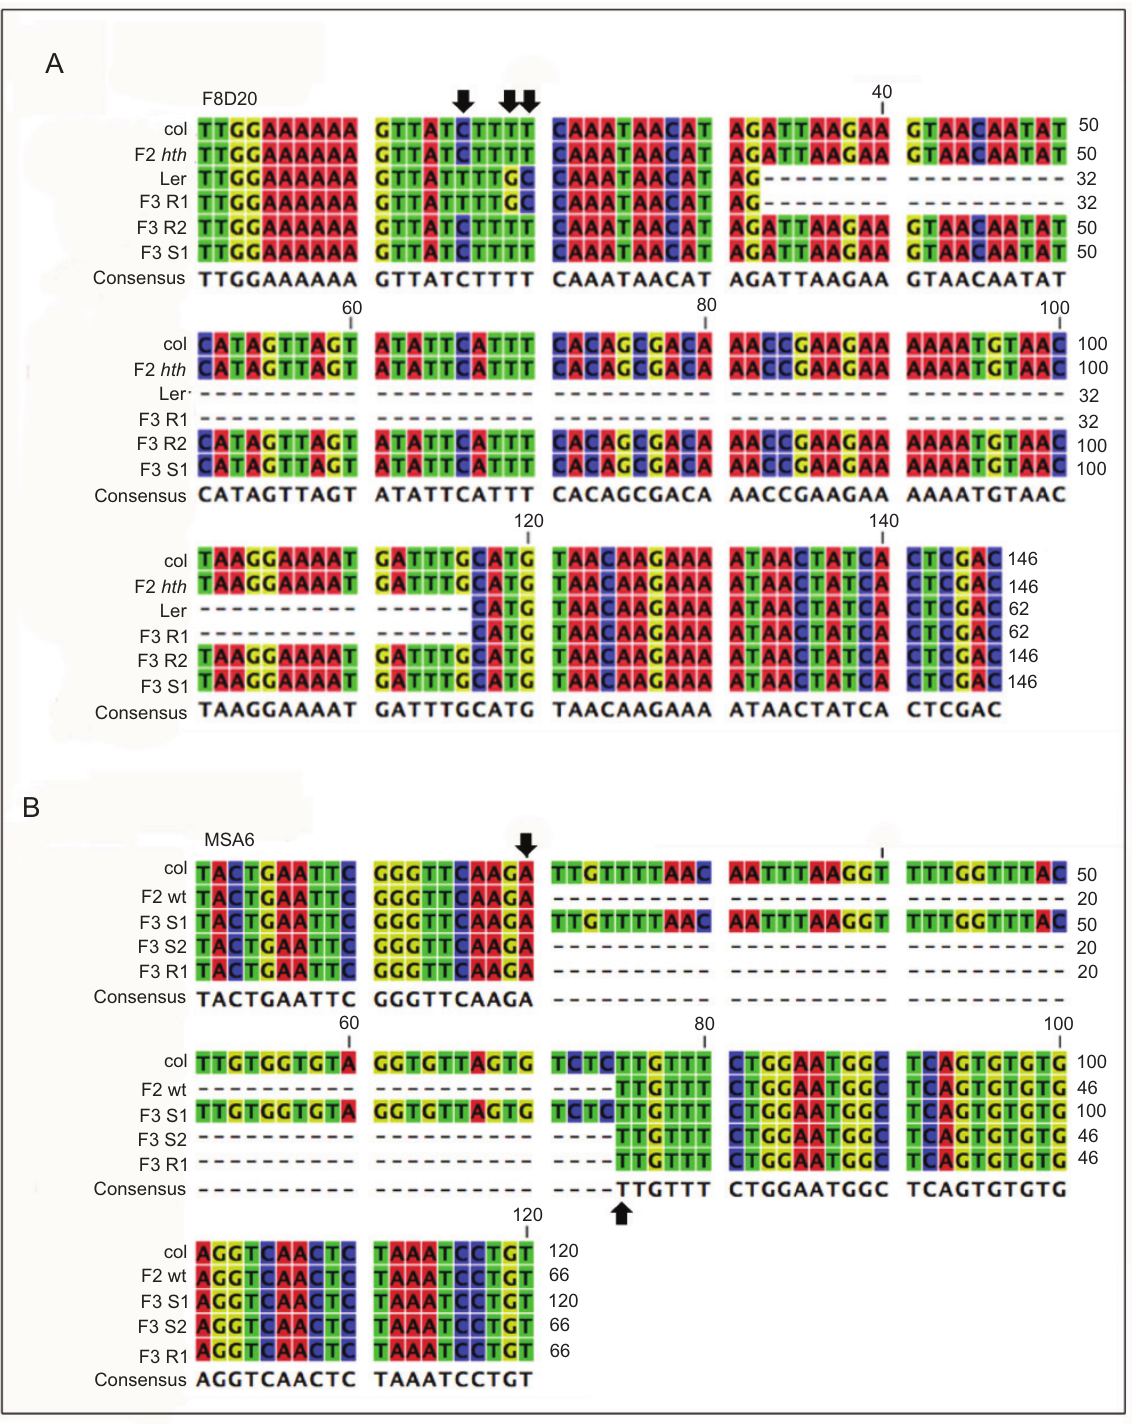
Figure 4. DNA sequence alignments showing F8D20 and MSA6 indel loci. ( A ) The F2 hth-3 parent (F2 hth ) shares sequence identity with 2 of 3 DNA clones isolated from this single hth-3 seedling (F3 R2 and F3 S1). DNA sequence data obtained from a root clone (F3 R1) shares identity with the Landsberg sequence (Ler), including 3 flanking sequence polymorphisms (arrows) and a corresponding 85 base-pair deletion. The Columbia reference sequence (Col) is shown on the top line of the alignment. ( B ) The HTH wt hybridparent (F2 wt) shares sequence identity with 2 of 3 DNA clones isolated from this single seedling (F3 S2 and F3 R1). DNA sequence data obtained from one shoot clone (F3 S1), however, reveals a 54 base-pair insertion sequence (junctions shown by arrows) and shares identity with the Columbia reference sequence